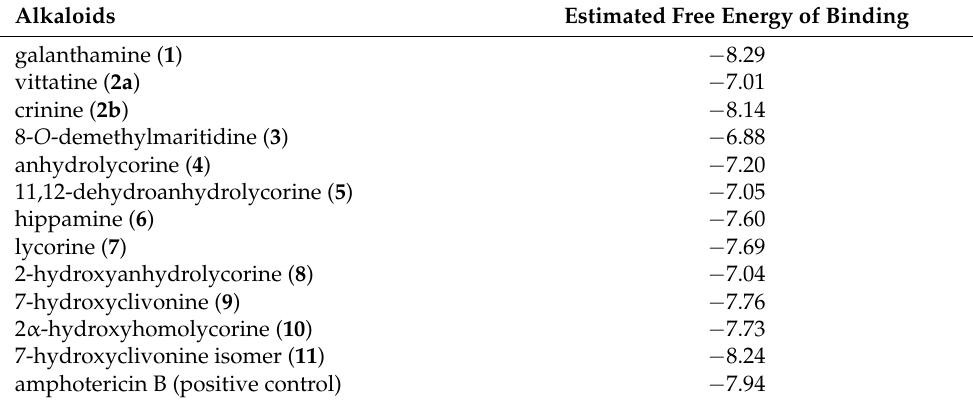
Table 2. Estimated Free Energy of Binding for the interaction between Leishmania braziliensis TR and the alkaloids. Values expressed in kcal · mol − 1